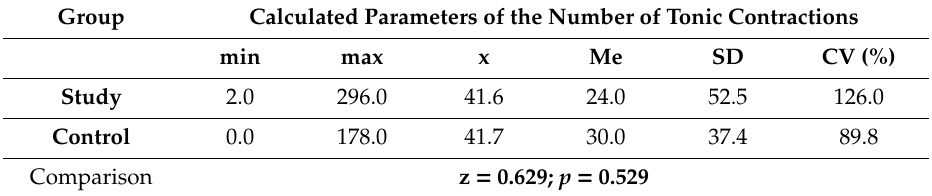
Table 8. Comparison of mean tonic contractions in patients in the study group and in the control group. Group Calculated Parameters of the Number of Tonic